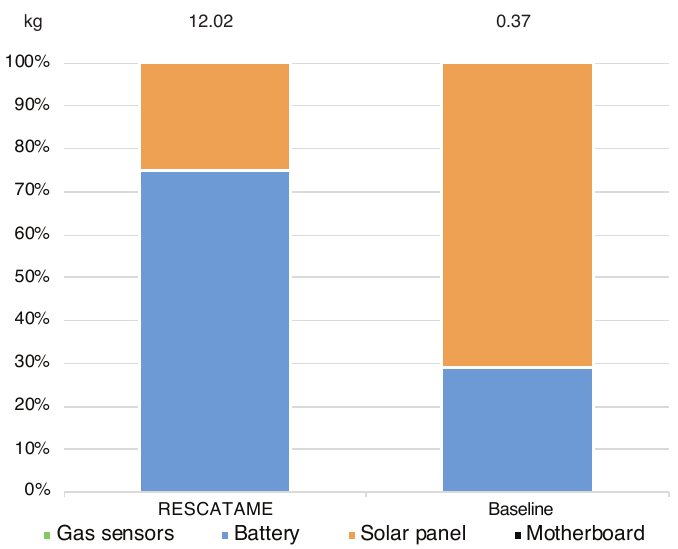
Figure 10. Waste impact of the maintenance of the RESCATAME project and baseline green solution.